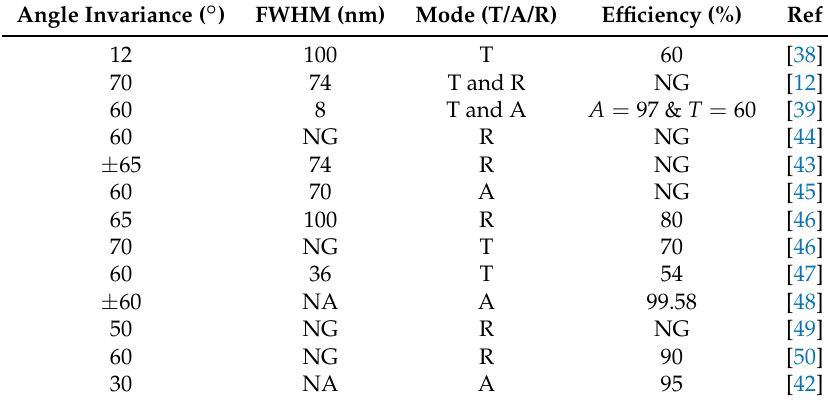
Table 1. Thin Films color